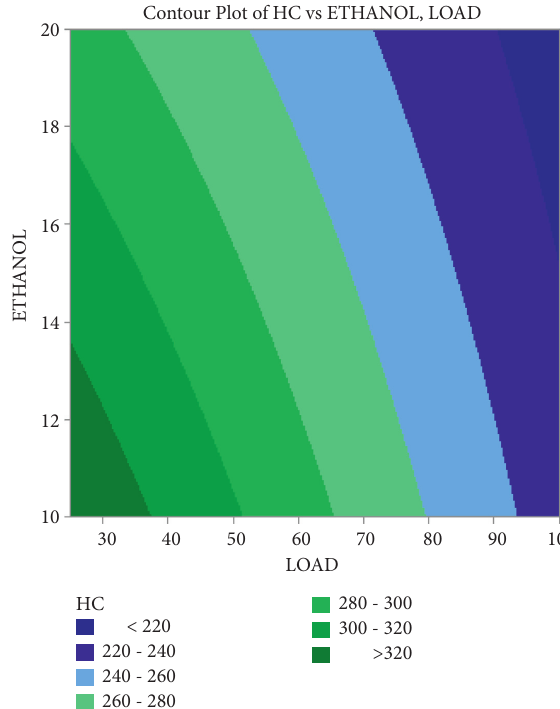
Figure 9: Contour plot of hydrocarbon on load and ethanol